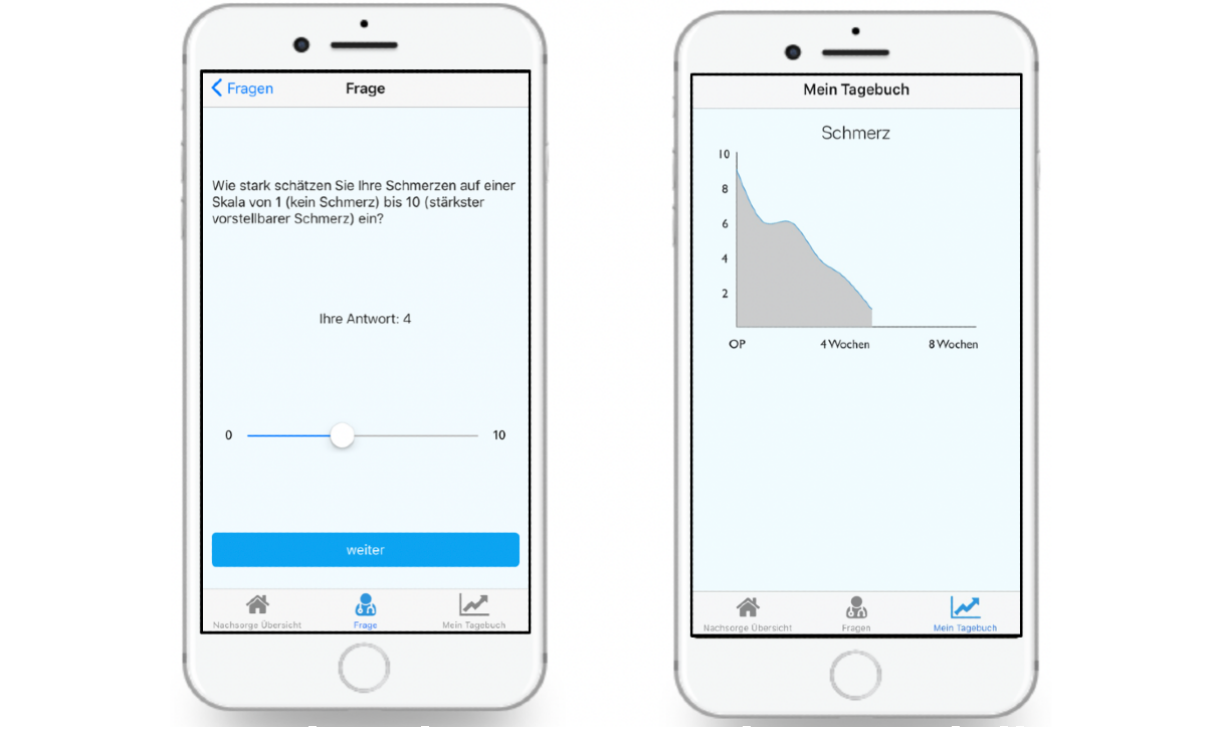
Figure 2. App screen view: (a) collection of patient-related data and (b) log function of patient-related